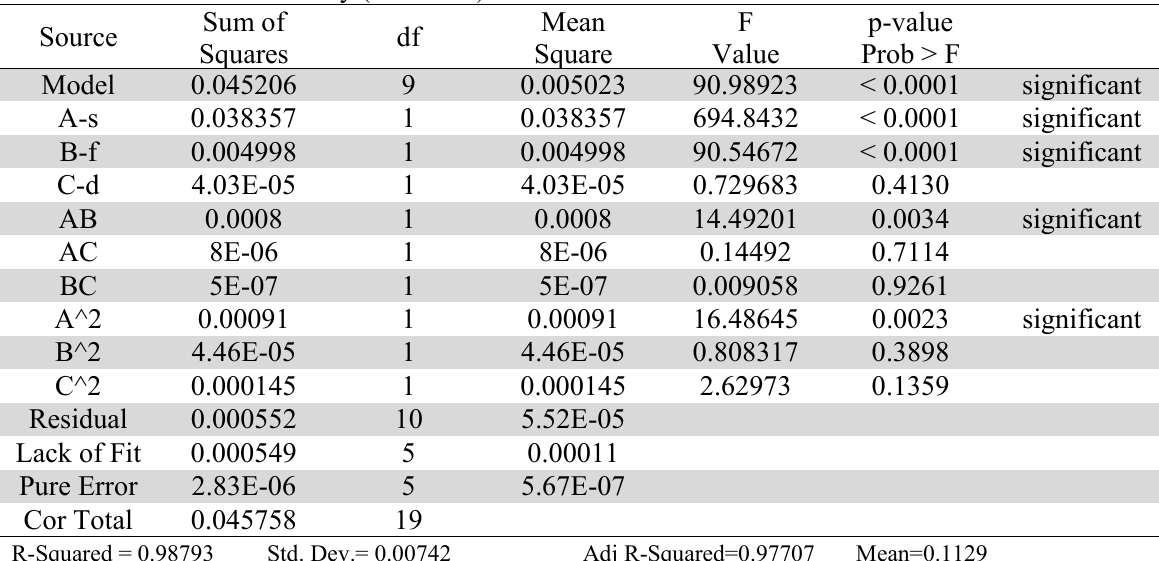
ANOVA results for Al-Si alloy (tool wear)